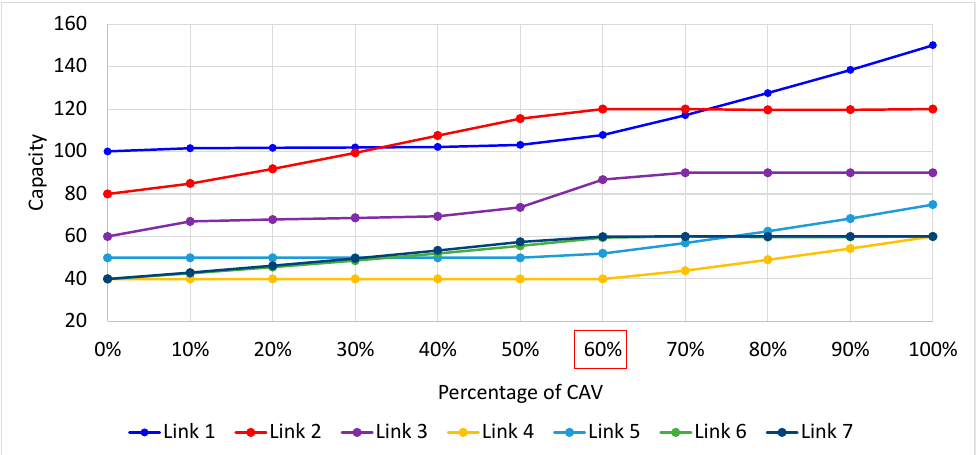
Figure 6. Trajectories of capacities.